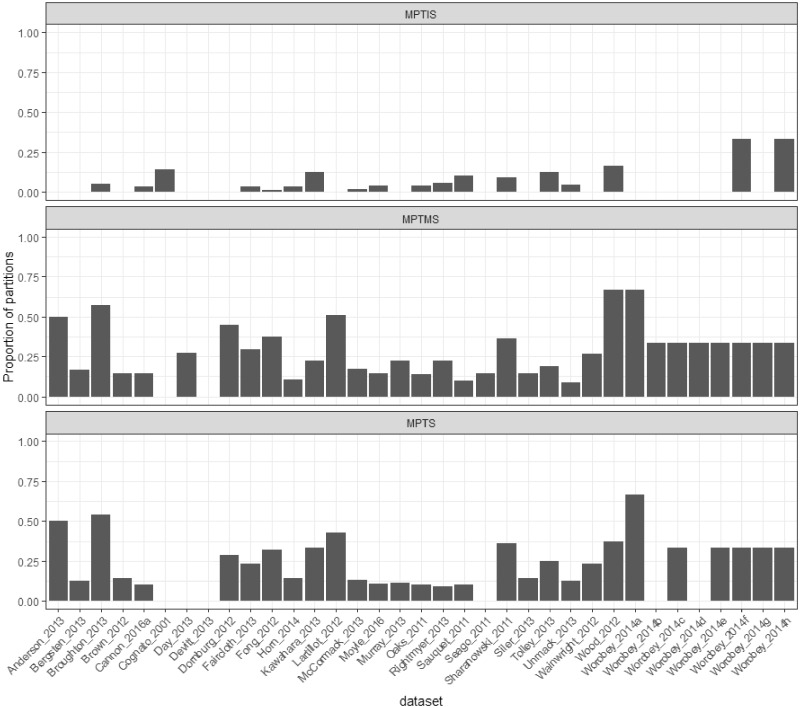
—The proportion of partitions that reject the null hypothesis of the MaxSymTest, MaxSymTestmar, and MaxSymTestint (P value <0.05) in each data set.